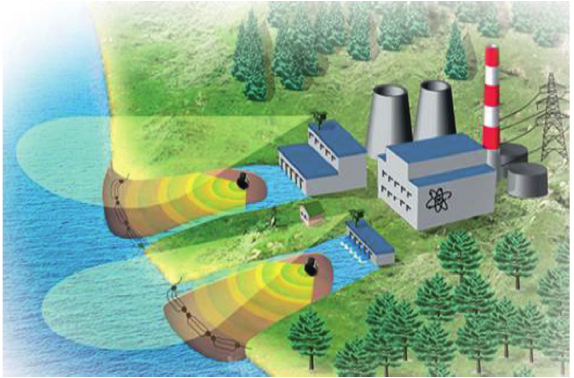
Figure 3: Underwater sonar as part of integrated